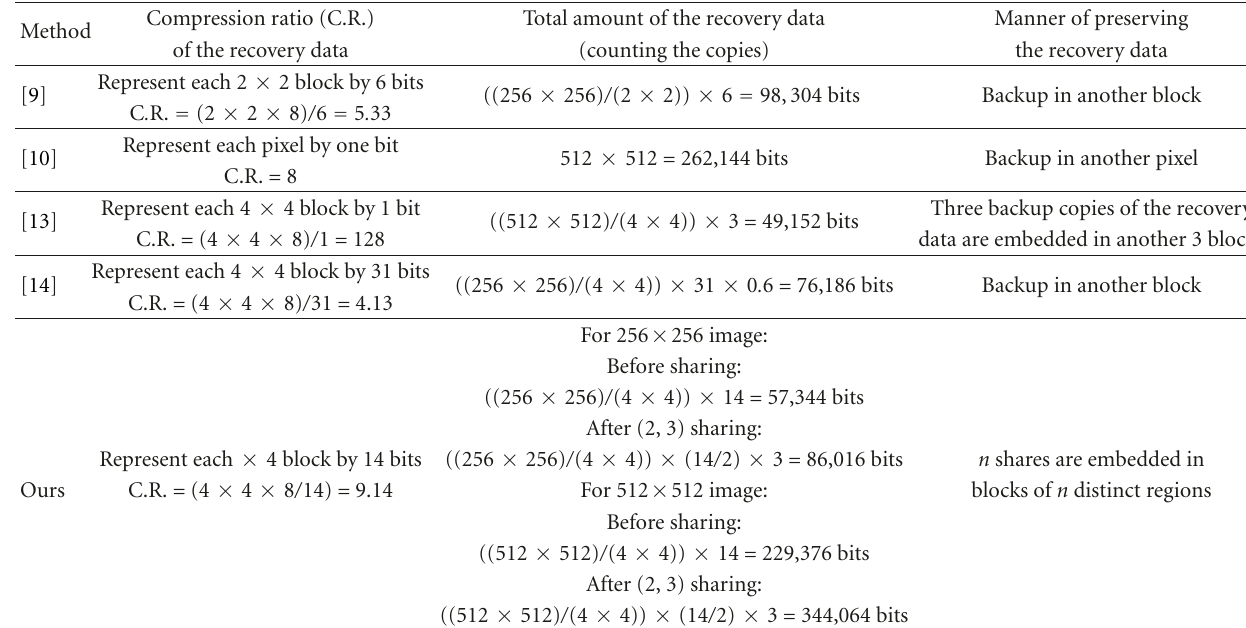
Table 2: Comparison of the size of recovery